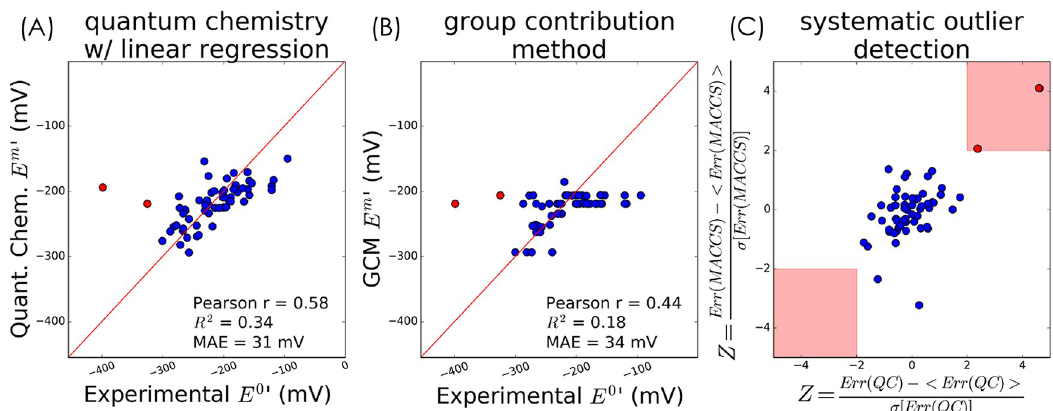
Fig 2. Quantum chemistry model predicts experimentally measured reduction potential with high accuracy. Data shown corresponds to reactions where carbonyls are reduced to hydroxycarbons (group G2). (A) Quantum chemical predictions after calibration (linear regression with 2-parameters); S2 Fig shows how the calibration improves accuracy. (B) Prediction using group contribution method as implemented in eQuilibrator [36,37] (see Methods) (10 parameters for the G2 category) (C) Scatter plot of normalized prediction errors (z-scores) of G2 reactions for molecular fingerprints and quantum chemistry. The indolelactate dehydrogenase (EC 1.1.1.110) and the succinate semialdehyde reductase (EC 1.1.1.61) reactions (red points) have potentially erroneous experimental